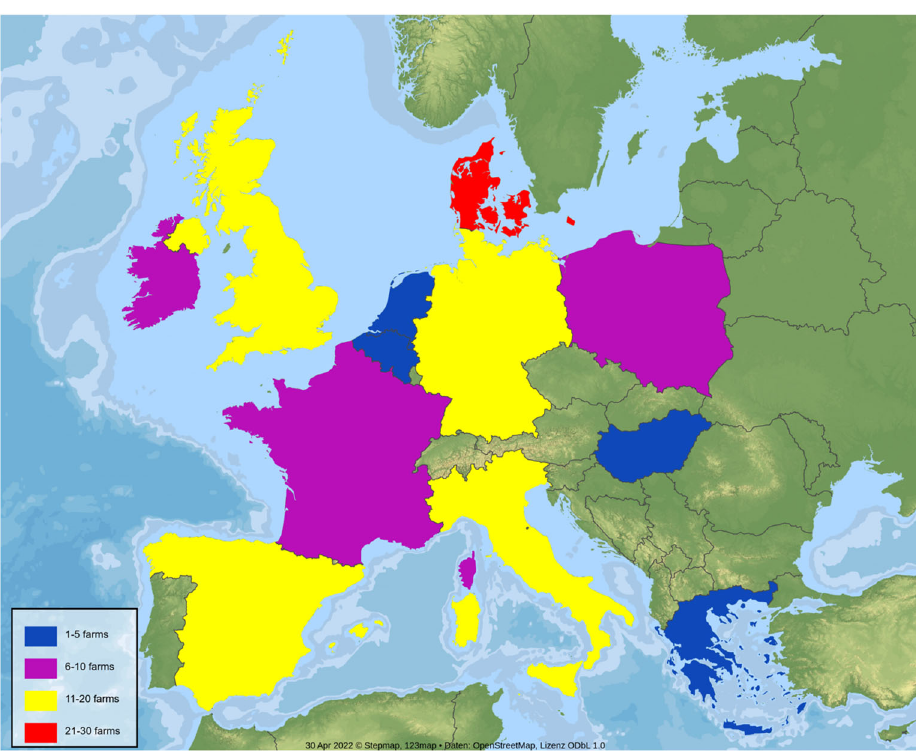
Figure 1. The 12 European countries that participated in the study, colored and sized differently according to the number of farms that were sampled in each country (blue: 1–5 farms, purple: 6–10 farms, yellow: 11–20 farms, red: 21–30 farms). This map was constructed using StepMap ® .